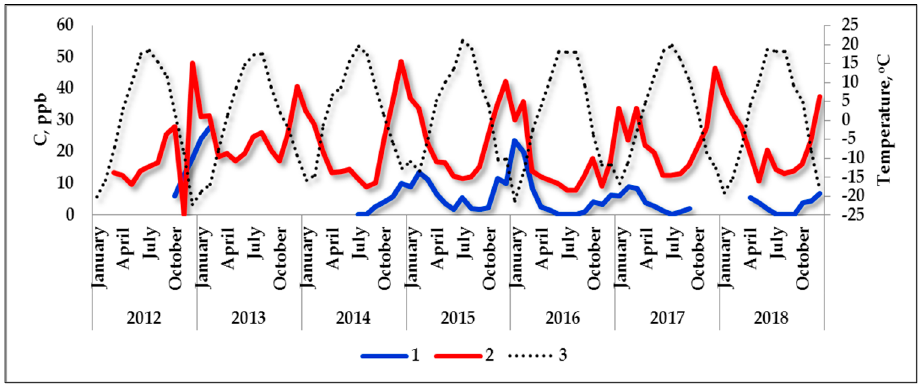
Figure 8. Seasonal and inter-annual variations in the concentrations of SO 2 (1) and NO x (2) in the atmosphere of Irkutsk City according to air temperature (3).